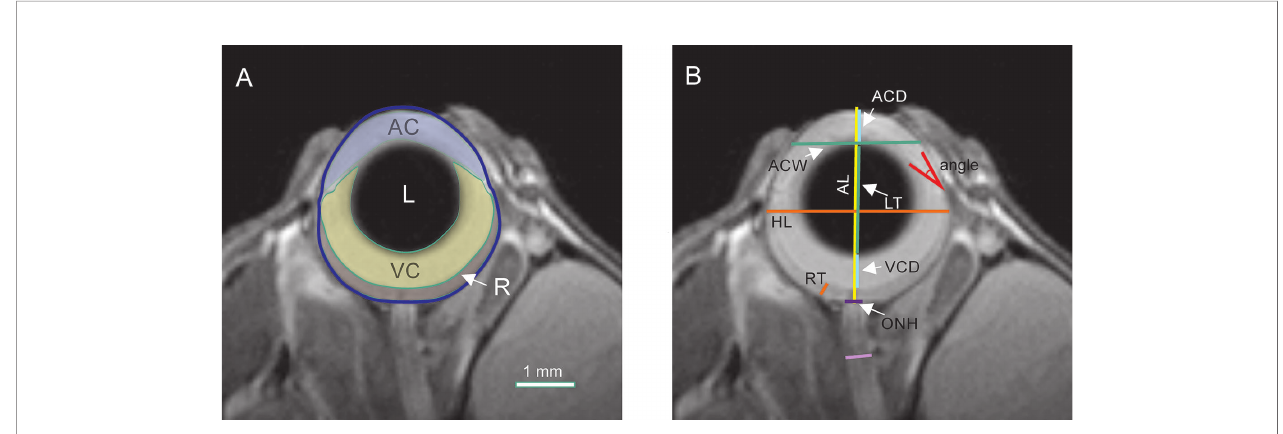
FIGURE 1 | Quanti fi cation of ocular morphology. (A) Areas of anterior chamber (AC), lens (L), vitreous chamber (VC), and retina (R). (B) Dimensions: axial length (AL), equatorial diameter (ED), anterior chamber depth (ACD), anterior chamber width (ACW), lens thickness (LT), vitreous chamber depth (VCD), retinal thickness (RT), optic nerve head diameter (ONH), and optic nerve diameter